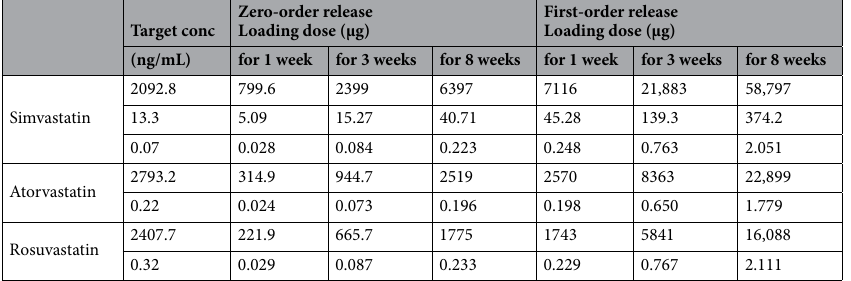
Table 3. Loading doses required for the statin drug delivery systems with zero- and first-order release rate in order to achieve 5 µM concentration (2092.8 ng/mL for simvastatin, 2793.2 ng/mL for atorvastatin and 2407.7 for rosuvastatin), the highest vitreal concentration measured in the vitreous of patients (0.07 ng/mL for simvastatin, 0.22 ng/mL for atorvastatin and 0.32 ng/mL for rosuvastatin) and the calculated simvastatin therapeutic concentration in PVR animal model 16 of 13.3